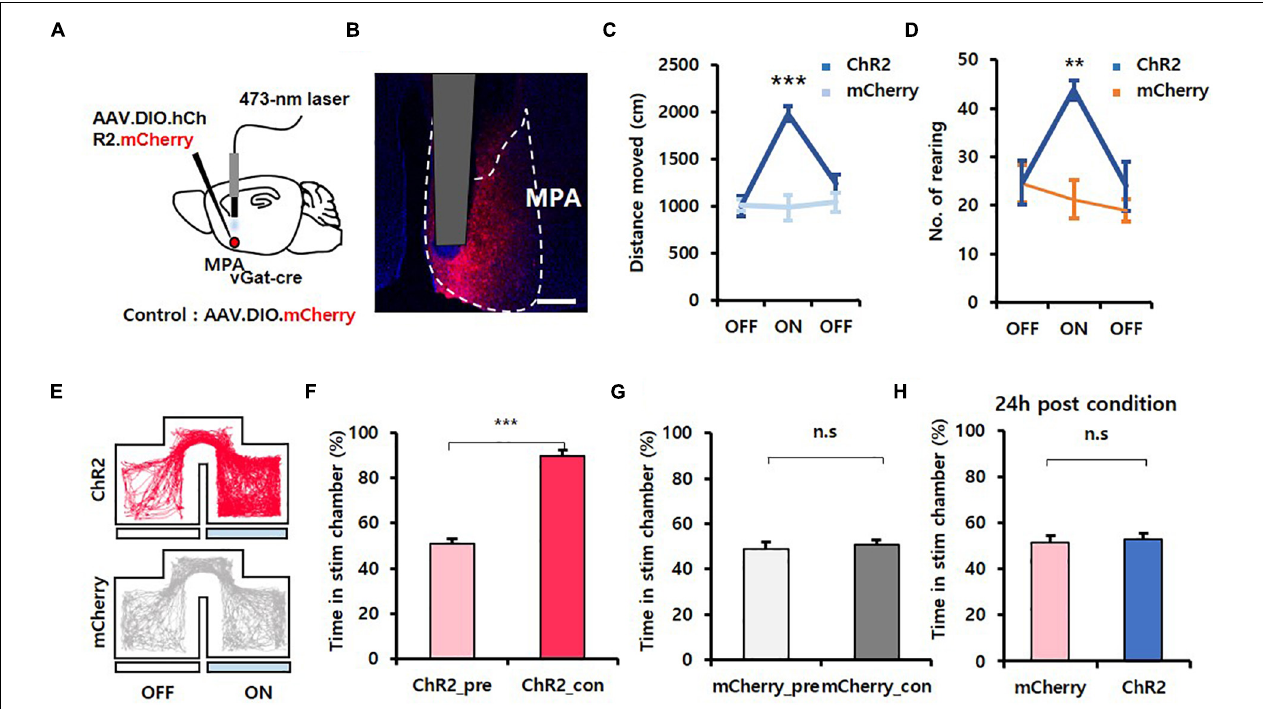
FIGURE 1 | Activation of MPA vgat neurons induces exploration but does not encode value. (A) Photoactivation of MPA vgat neurons. Viruses were injected into the MPA, and fiber-optic cannulas were implanted above the injection site. (B) Virally mediated expression of ChR2 in MPA neurons of vgat -ires- Cre mice. Scale bar, 250 µ m. (C) Photostimulation of MPA vgat neuron increases movement in ChR2-expressing mice ( n = 6; n = 3 males; n = 3 females) compared to mCherry control mice ( n = 4; n = 1 male; n = 3 females); *** p < 0.001. Error bars represent SD. (D) Number of rearing increases during photostimulation of ChR2-expressing mice ( n = 6; n = 3 males; n = 3 females) compared to control mice ( n = 4; n = 1 male; n = 3 females); ** p < 0.01. Error bars represent SD. (E) Representative movement trace of ChR2-expressing (red) mice and mCherry control (gray) mice during RTPP. (F) ChR2-expressing ( n = 6; n = 3 males; n = 3 females) mice show real-time preference toward the stim chamber; *** p < 0.001. Error bars represent SD. (G) mCherry control ( n = 4; n = 1 male; n = 3 females) do not show real-time place preference toward the stim chamber; p = 0.36. Error bars represent SD. (H) Conditioned place preference test 24 h after photostimulation with one chamber. mCherry control ( n = 4; n = 1 male; n = 3 females) and ChR2-expressing ( n = 6; n = 3 males; n = 3 females) mice do not have preference toward the stim chamber; p = 0.753. Error bars represent